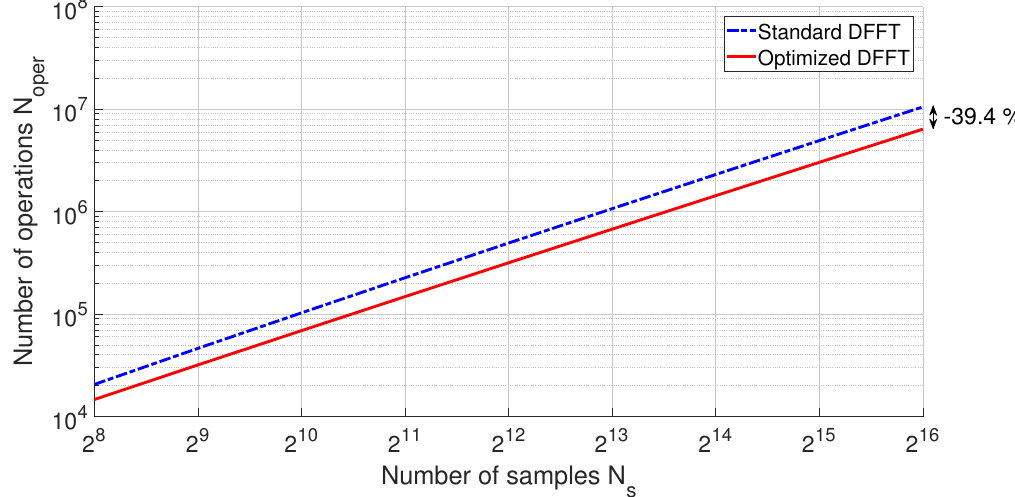
Figure 2. Number of operations (sums and multiplications) required to evaluate the discrete fast Fourier transform (DFFT) according to the classical algorithm (dashed-dot line) and to the optimized one (continuous